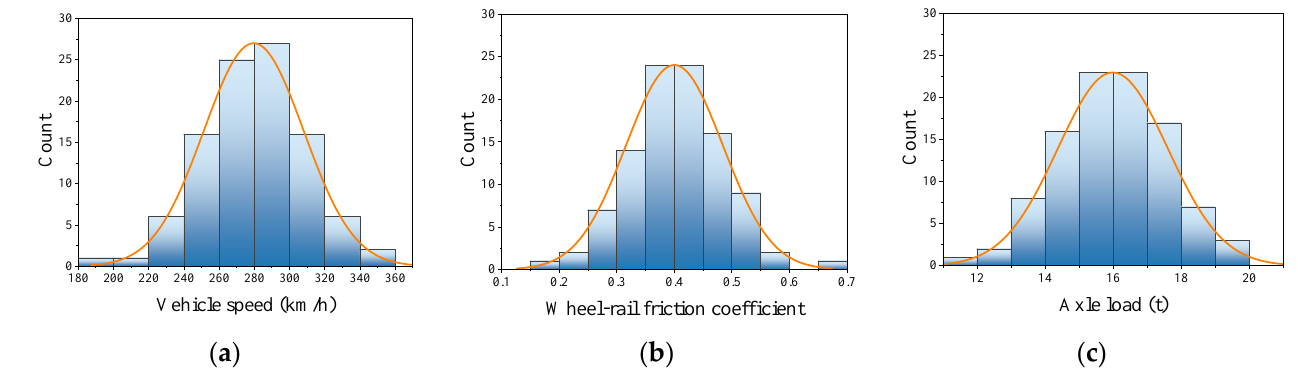
Figure 8. Random sample: ( a ) Vehicle speed; ( b ) Wheel-rail friction coefficient; ( c ) Axle load. The vehicle-turnout dynamics analysis process based on the LHS method is shown in Figure 9. One hundred groups of random samples are used as input parameters for the dynamic model. The variation patterns of wheel-rail forces, safety, and comfort indicators are calculated under different wavelengths of irregularities in front of the turnout. Finally, the combined effects of irregularities in front of turnout on vehicle dynamic responses are further analyzed in the time domain and frequency domain. Figure 9. Calculation process based on the stochastic method. 4. Result Analysis 4.1. Simulation of Track Irregularity Generally, compared with the vehicle passing straight through the turnout, the dy- namic behavior and safety of the vehicle passing through the diverging track of the turn- out are worse. However, it is challenging to analyze the influence of track irregularity on